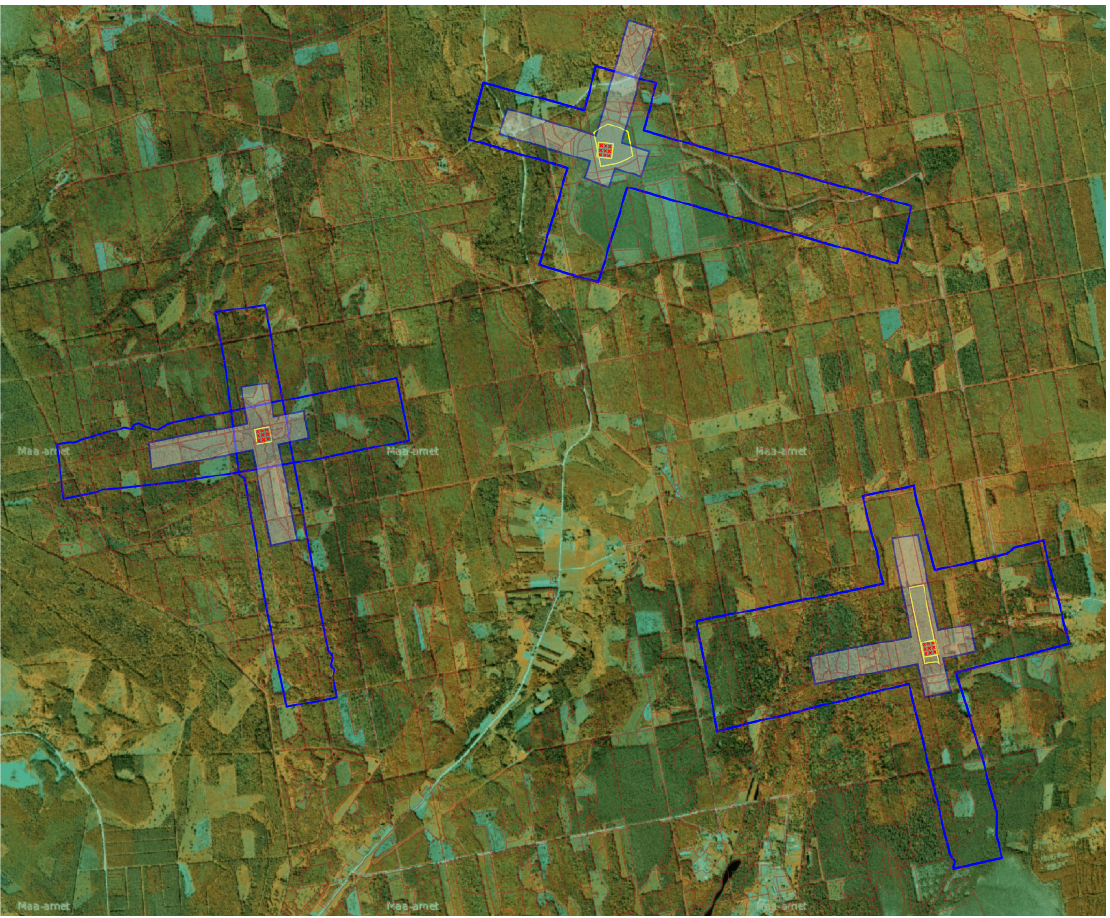
Figure 1. Map of the test site. Yellow squares are the RAMI stands, red points are the leaf area index (LAI) points in RAMI stands, empty blue polygons mark the area of airborne laser scanner (ALS) data in 2017, and filled polygons mark the area of ALS data in